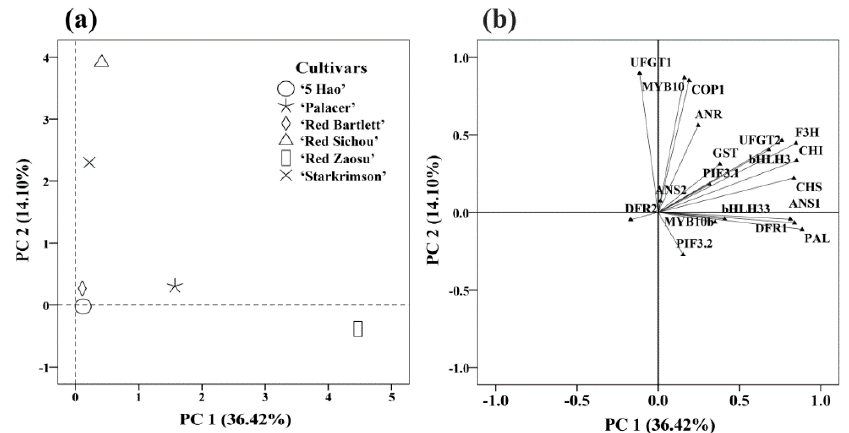
Figure 5. Principal component analysis of the skin of six red pears at different stages of fruit development. ( a ) Discrimination of six cultivars. ( b ) Loading plots of metabolites and transcripts for the first two principal components (PC1 and PC2).